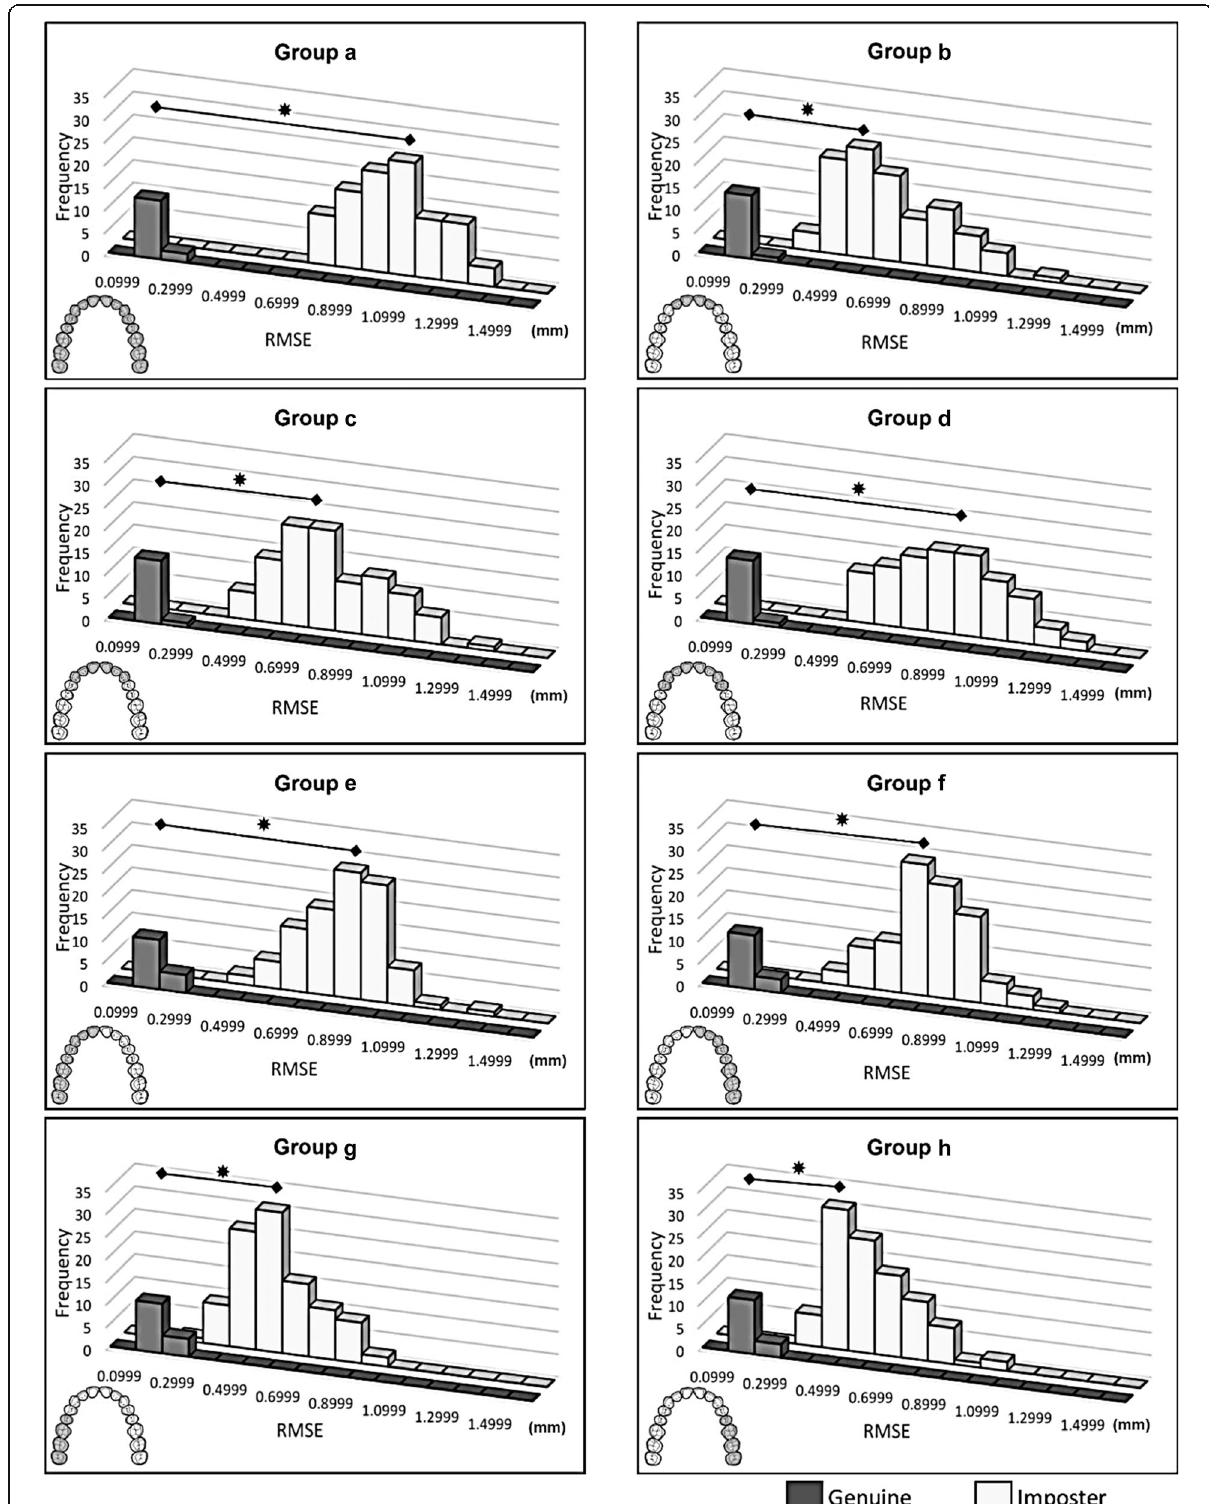
Fig. 8 The distribution pattern of root mean square errors (RMSEs) of the three-dimensional data for the genuine and imposter pairs in experiment 1 (Groups a – h